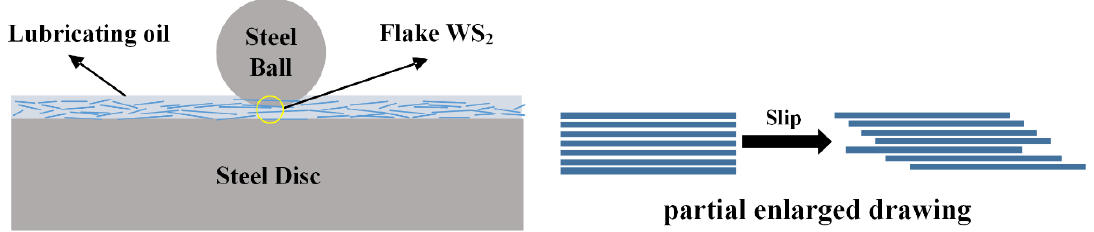
Figure 13. Lubrication mechanism of flaky WS 2 as lubricating oil additive (steel ball and disk). ( Left : overall schematic) ( Right : schematic details).